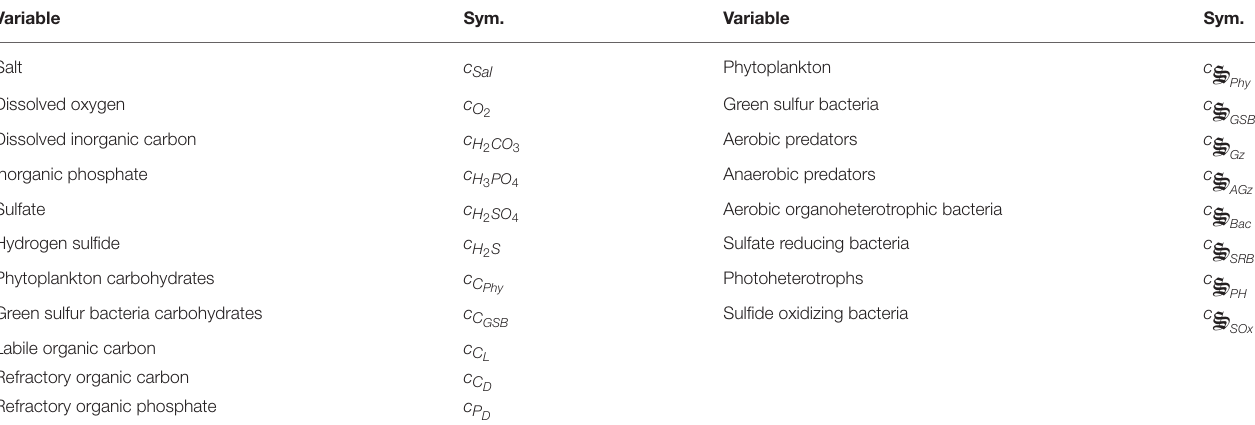
TABLE 1 | Names of state variables and associated symbols. Variable Sym.